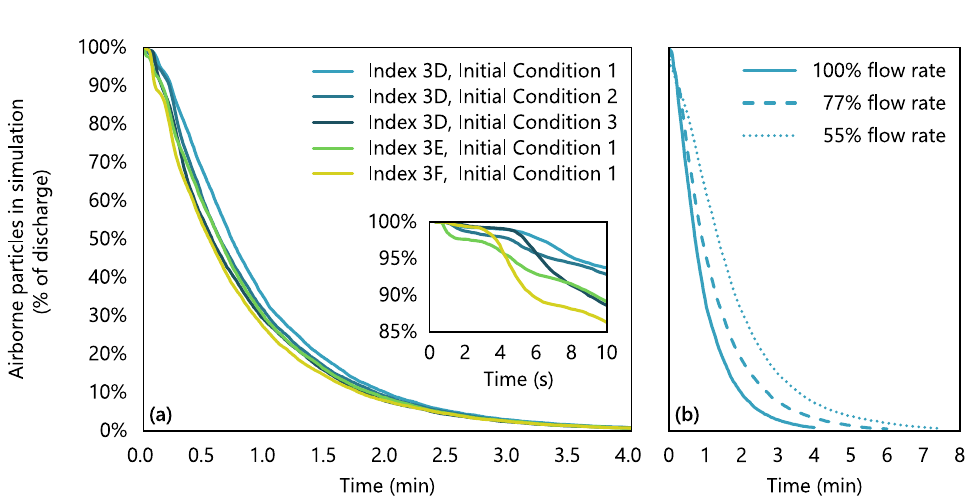
Figure 2. Velocity vectors of initial conditions at 100% flow rate with the highest velocities shown in red and the lowest ones in blue. Time offset and initial condition index as follows: ( a ) 0 s, Initial Condition 1, ( b ) 90 s, Initial Condition 2, ( c ) 120 s, Initial Condition 3.